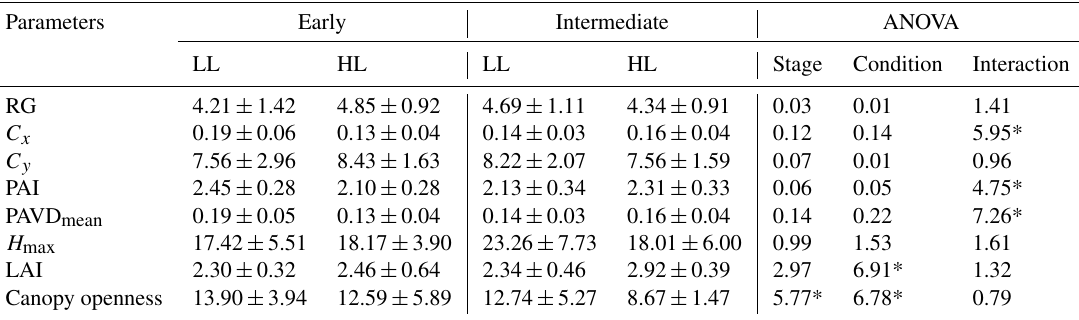
Table 2. Mean ( ± SD) of parameters calculated by the VEGNET system and HPs in plots with different successional stages and different relative abundance of lianas in the dry forest at the Santa Rosa National Park in Costa Rica. Significant differences ( F values and their p values) according to the successional stages, relative abundance of lianas, and their interaction are represented by a posteriori ANOVA text extracted from the MANOVA. RG, radius of gyration; PAI, plant area index; PAVD mean , plant area volume density; H max , maximum tree height (m); LAI, leaf area